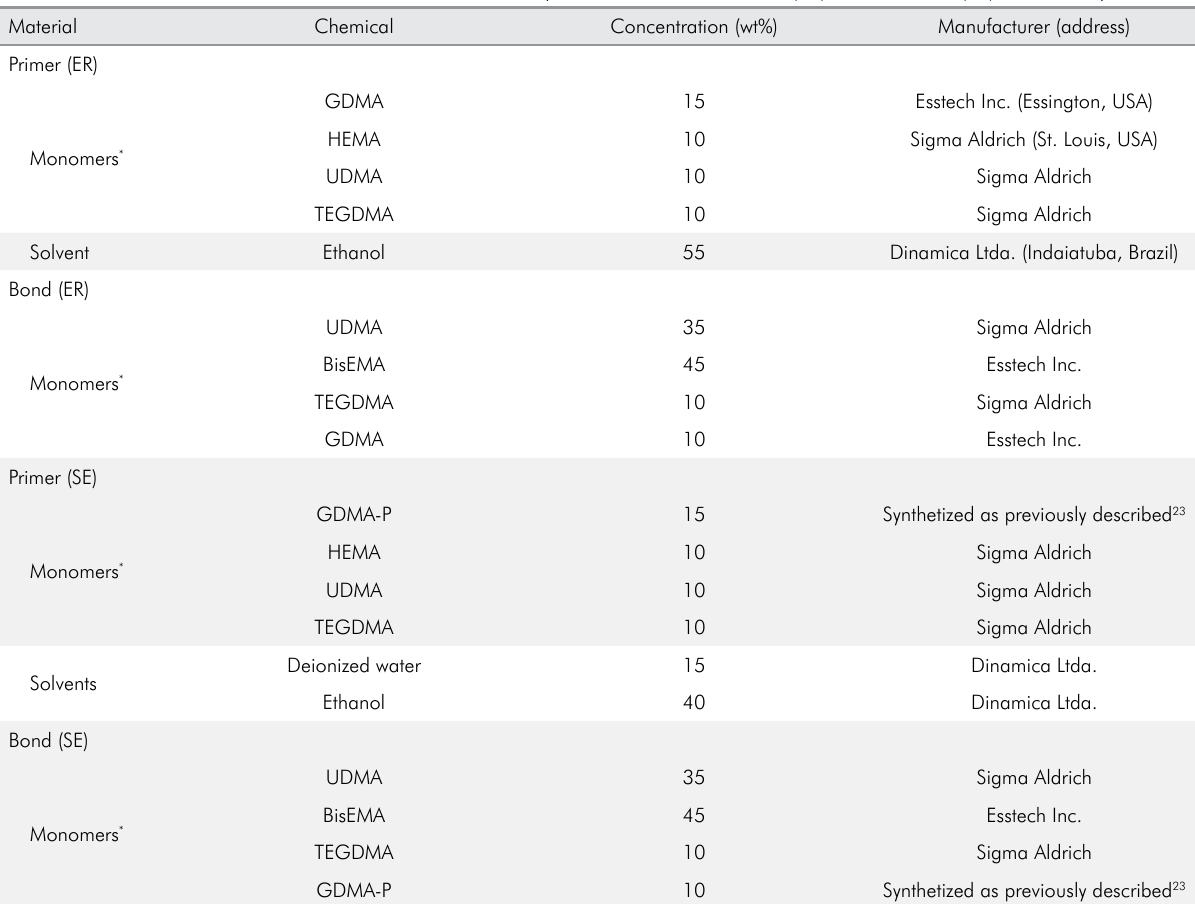
Table 1. Monomers and solvents used to formulate the experimental etch-and-rinse (ER) and self-etch (SE) adhesive systems. Material